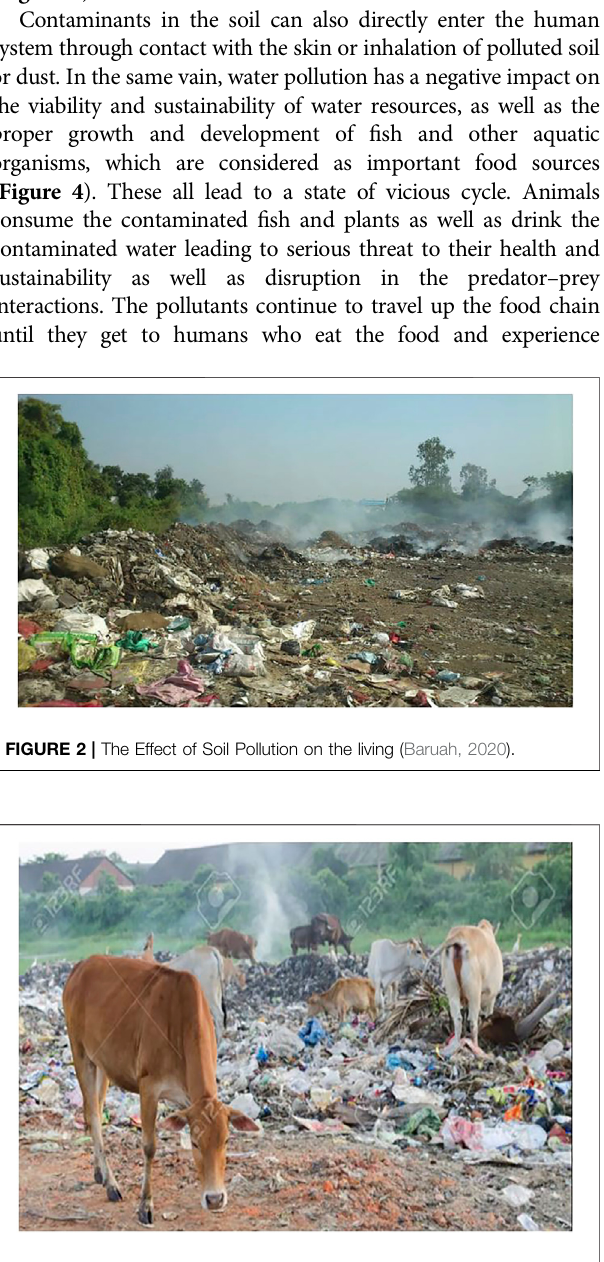
Frontiers in Physiology |